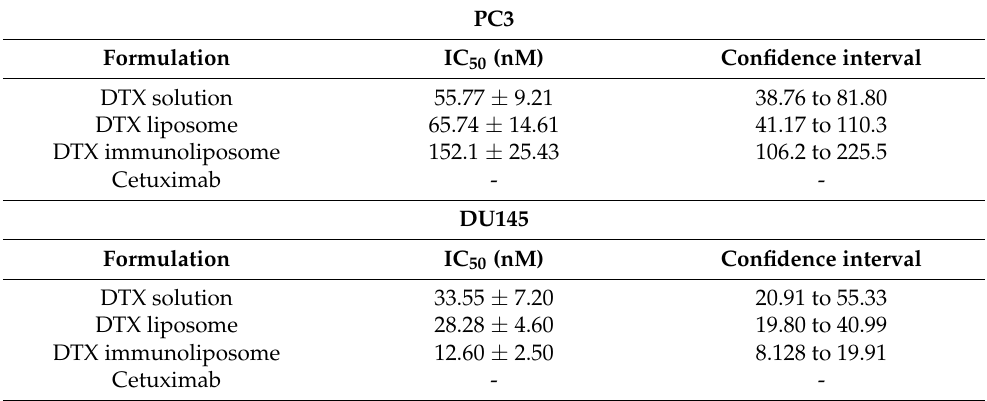
Table 5. IC 50 of the formulations tested in the two cell lines (PC3 and DU145) with their respective confidence